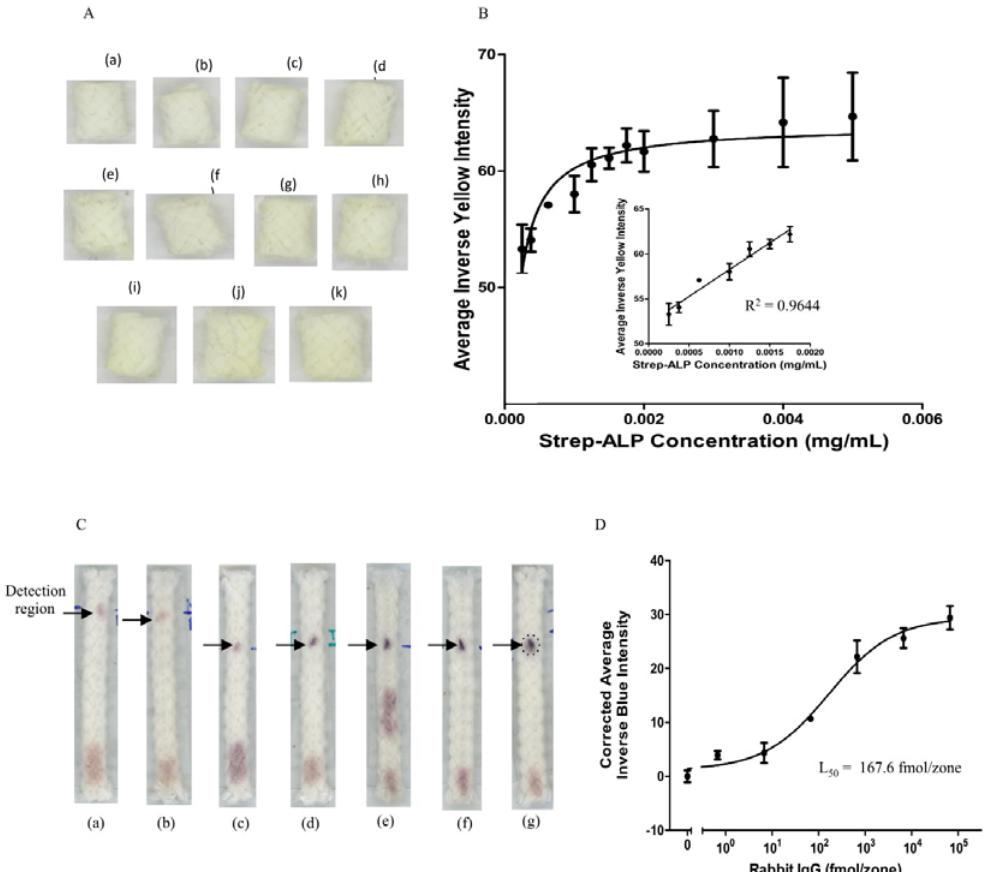
Figure 2. Images of increasing concentrations of ( A ) Strep-ALP: (a) 2.50 × 10 − 4 mg / mL (b) 3.75 × 10 − 4 mg / mL, (c) 6.25 × 10 − 4 mg / mL, (d) 1.00 × 10 − 3 mg / mL, (e) 1.25 × 10 − 3 mg / mL, (f) 1.50 × 10 − 3 mg / mL, (g) 1.75 × 10 − 3 mg / mL, (h) 2.00 × 10 − 3 mg / mL, (i) 3.00 × 10 − 3 mg / mL, (j) 4.00 × 10 − 3 mg / mL, and (k) 5.00 × 10 − 3 mg / mL. ( B ) Inverse yellow mean value intensities as a function of Strep-ALP concentration. Insert is Strep-ALP concentrations ranging from 2.50 × 10 − 4 –1.75 × 10 − 3 mg / mL. Data are presented as the average ± SD from three independent measurements. The error bars reflect the standard deviations from the average values. ( C ) Images of increasing rabbit IgG antigen concentrations: (a) 0 fmol / zone, (b) 0.7 fmol / zone, (c) 6.7 fmol / zone, (d) 67 fmol / zone, (e) 670 fmol / zone, (f) 6700 fmol / zone, and (g) 67000 fmol / zone. ( D ) The sigmoidal curve of corrected inverse blue Intensity as a function of rabbit IgG in fmol / zone (L 50 = 167.6 fmol / zone). Data are presented as the average ± SD from three independent measurements. The error bars reflect the standard deviations from the average values.